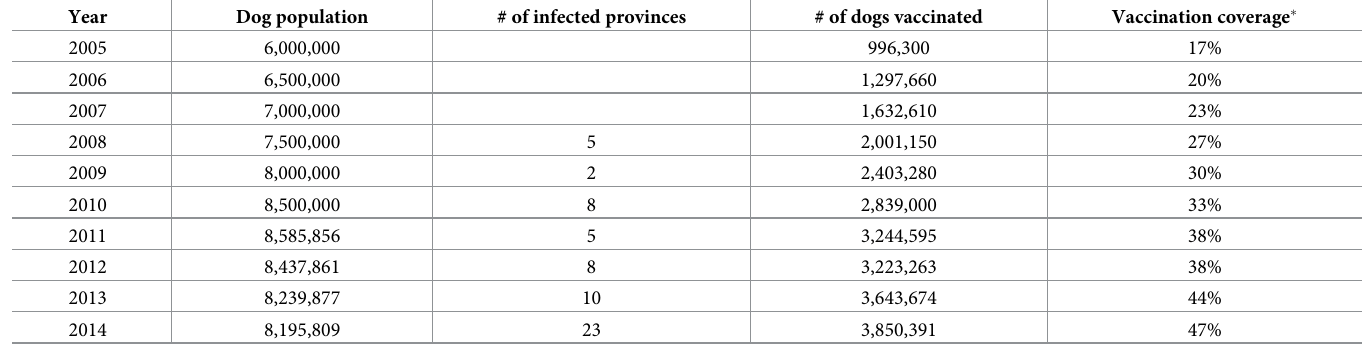
Table 3. Dog population and canine vaccine coverage in Viet Nam between 2005 and